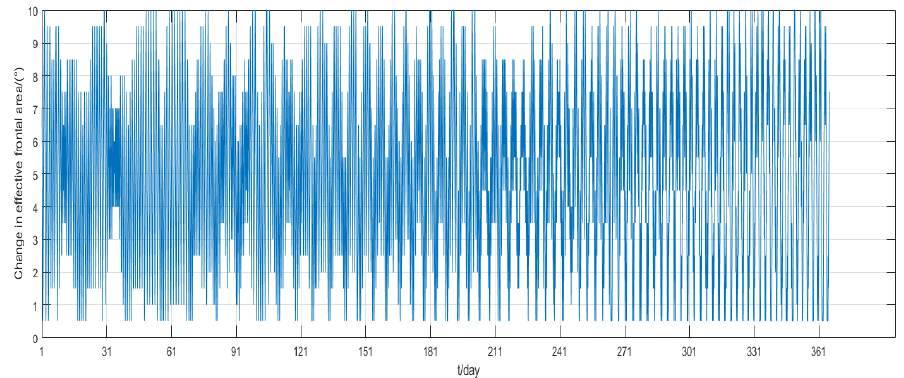
Figure 17. One-year change of frontal